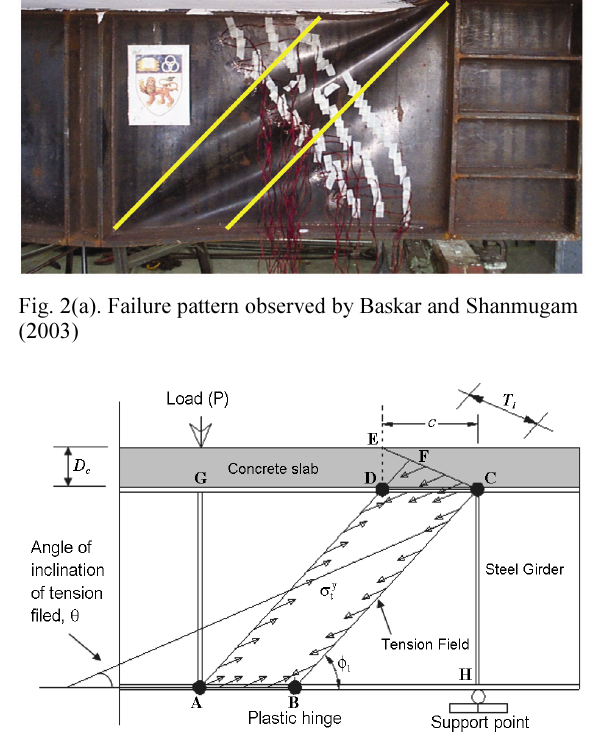
Fig. 2(b). Failure mechanism assumed by Shanmugam